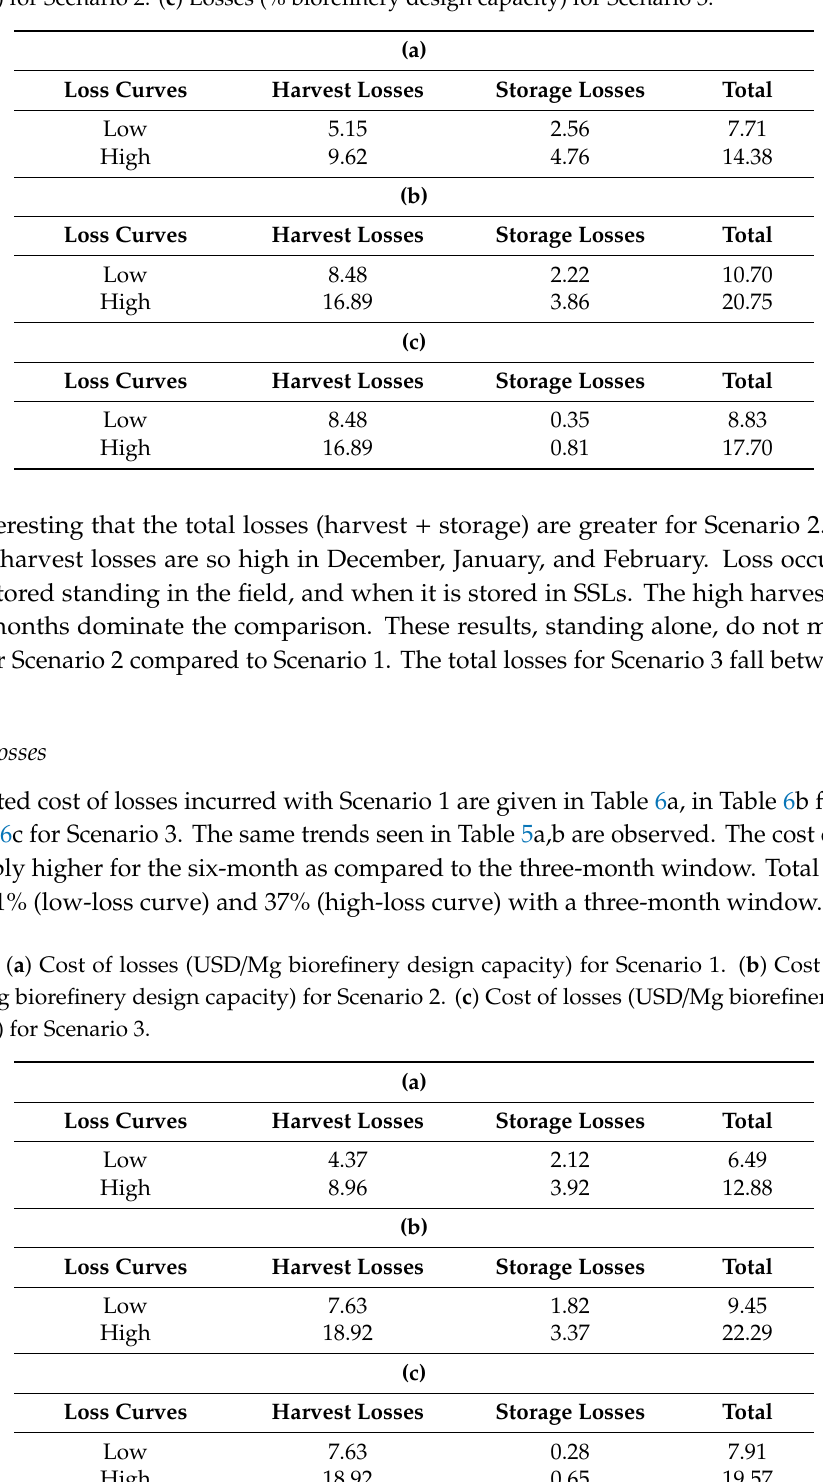
Table 5. ( a ) Losses (% biorefinery design capacity) for Scenario 1. ( b ) Losses (% biorefinery design